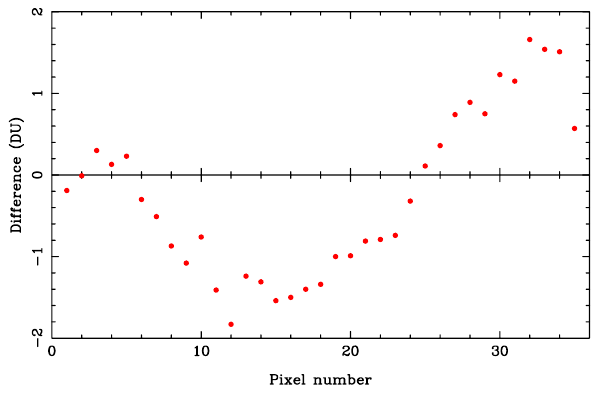
Fig. A1. The viewing angle correction for